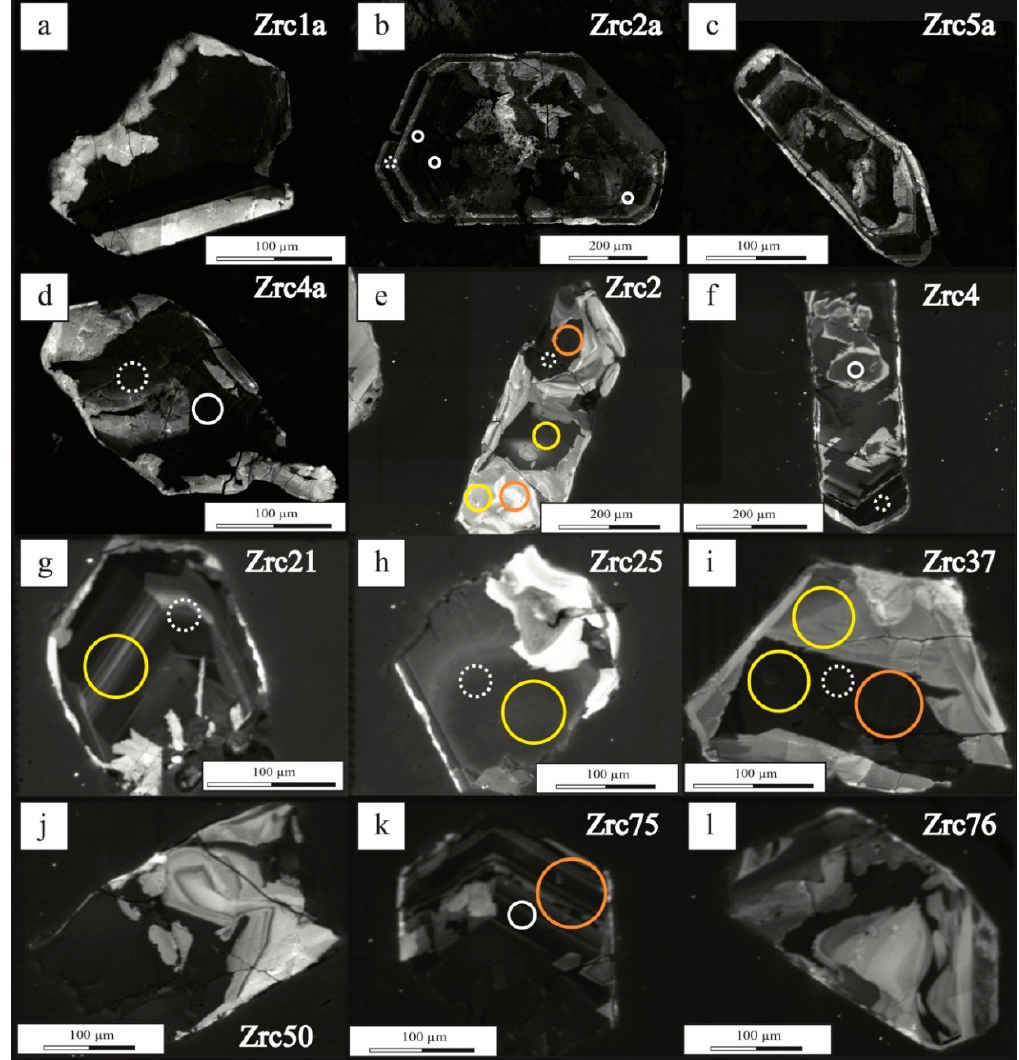
Figure 7. ( a – l ): SEM-cathodoluminescence (CL) image of zircon grains for sample SB08. The spot analyses are reported as circles: White dotted and solid circles refer to U–Pb concordant and discordant data, respectively; yellow and orange circles refer to trace element and Lu–Hf spot analyses.